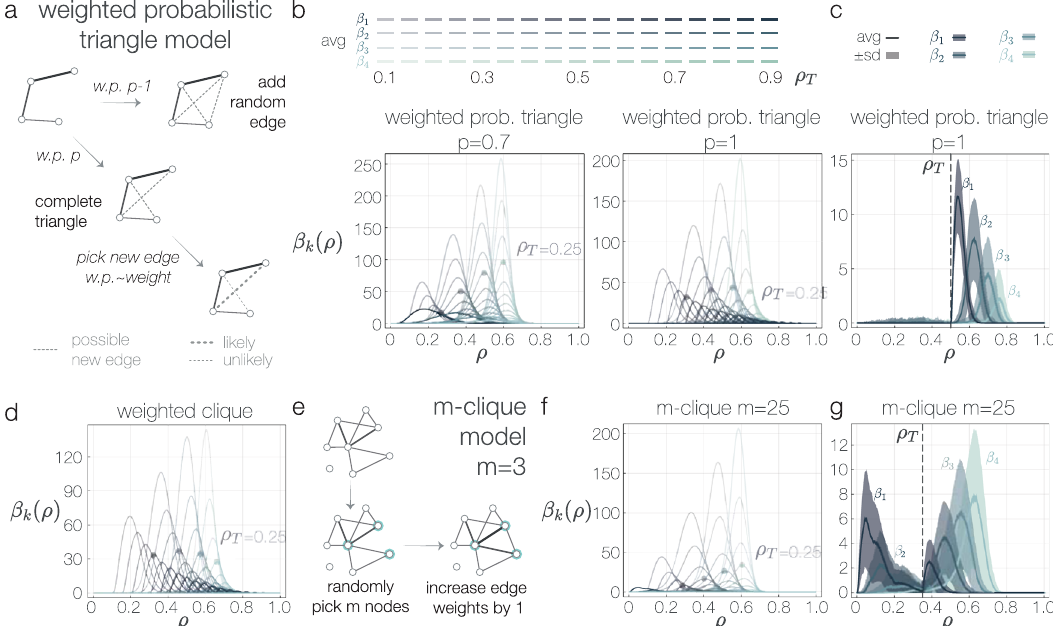
Fig. 5 Cliques and triangles support different patterns of added noise Betti curves. a The weighted probabilistic triangle model proceeds by adding edges either at random or to complete an open triangle. The likelihood of completing a speci fi c open triangle is based on the weight of its edges. b Betti curves at varying values of threshold density ρ T for the weighted probability triangle with probability (w.p) p = 0.7 and p = 1, with dots marking curves corresponding to ρ T = 0.25. Color of the curves correspond to colors in the legend above the panels. c Average (solid lines) and ±standard deviation ( fi lled area) for Betti curves of the weighted probabilistic triangle model with probabily p = 1, ρ T = 0.5 (right). d Betti curves at varying values of ρ T for the clique graph. e The random m -clique model creates a weighted network by selecting m nodes at random, increasing all edge weights between these nodes by 1, and repeating the process. f Betti curves across all values of ρ T and g for ρ T = 0.35 for the m -clique model with m = 25. Legends the same as for panels b , c ,